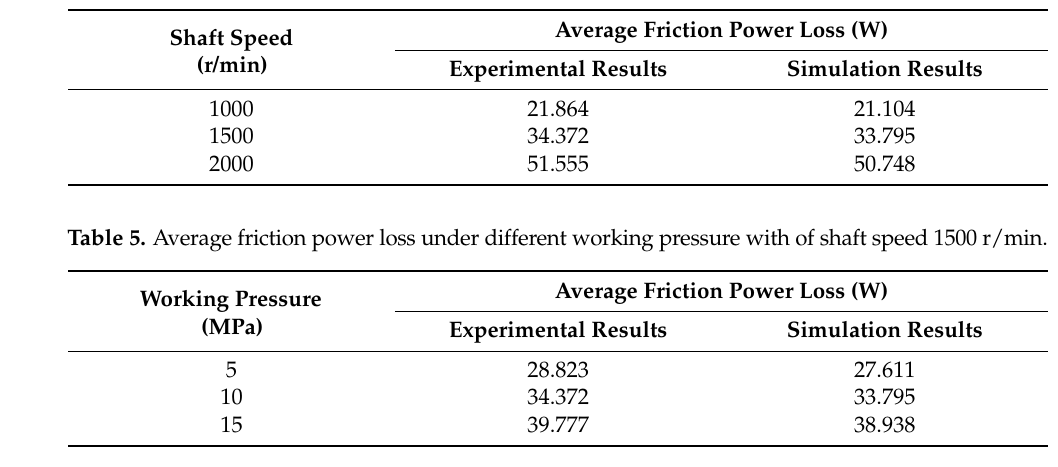
Table 4. Average friction power loss under different shaft speed with working pressure of 10 MPa.